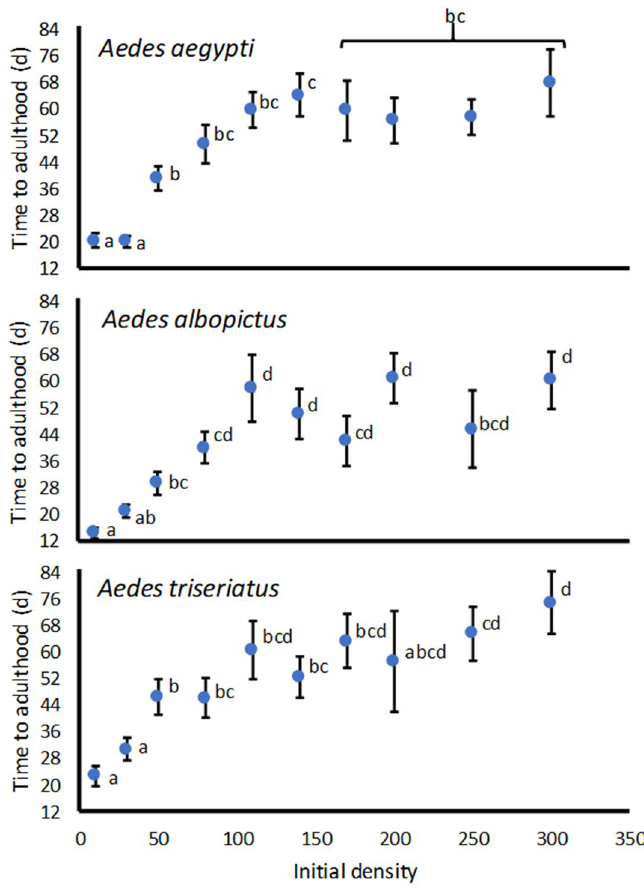
Figure 4. Least squares mean ± SE of cohort median female time to adulthood for Aedes aegypti, Aedes albopictus, and Aedes aegypti, averaged over replicate runs for each species. Least squares means for a species associated with the same letters are not significantly different by Tukey’s multiple